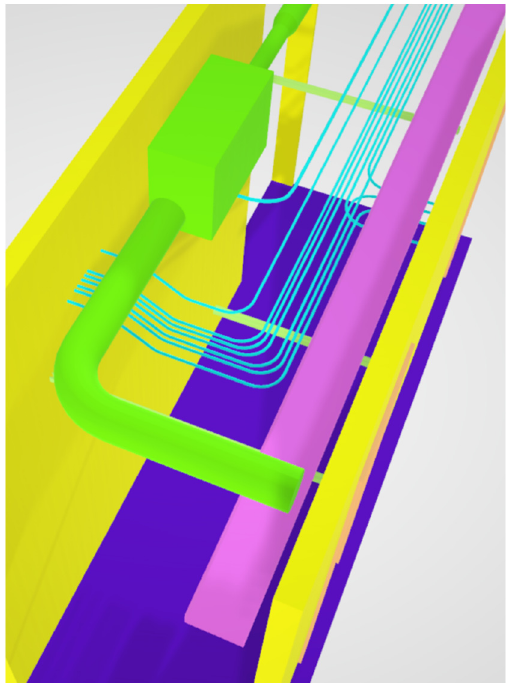
Figure 3. Colored model used for the augmented reality (AR) environment.